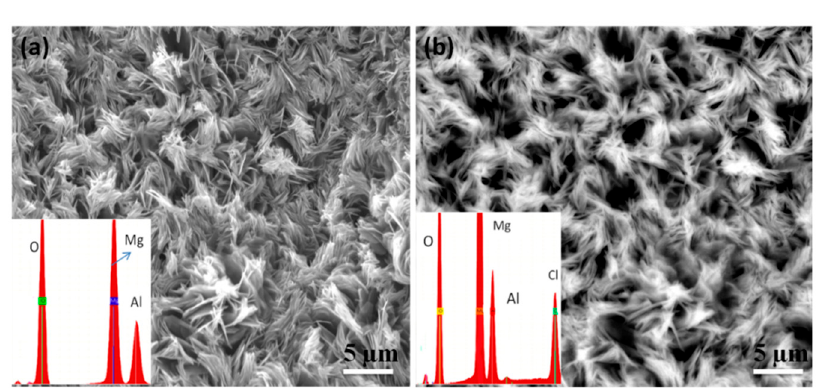
Figure 10. The specimens after 7 days of immersion in a solution of 0.1 M NaCl: ( a ) bare aluminum surface; ( b ) coated sample at 60 °C–24 h; ( c ) 80 °C–18 h; ( d ) 80 °C–24 h; and ( e ) 100 °C–18 h. Figure 11. SEM images of ( a ) original MgAl LDH coating, 60 °C–24 h sample and ( b ) an immersed sample soaked in 0.1 M NaCl solution for 7 days (Insets are the corresponding EDS spectra).